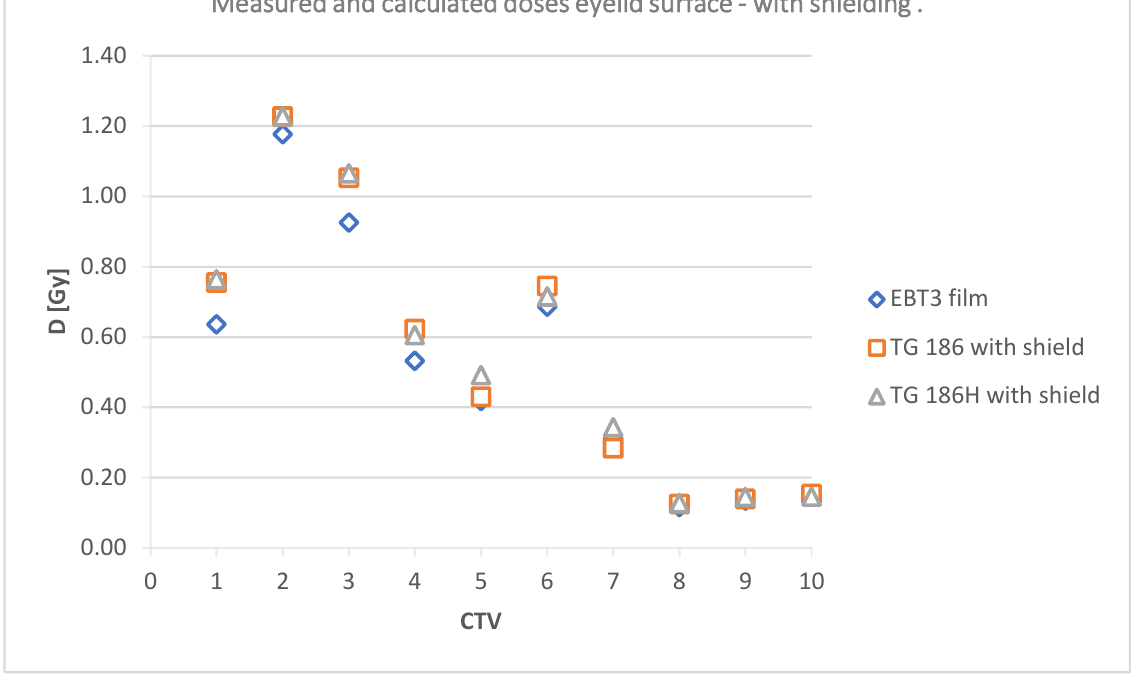
Figure 16. Doses at a point in the center of the lens of the eye with a shield.